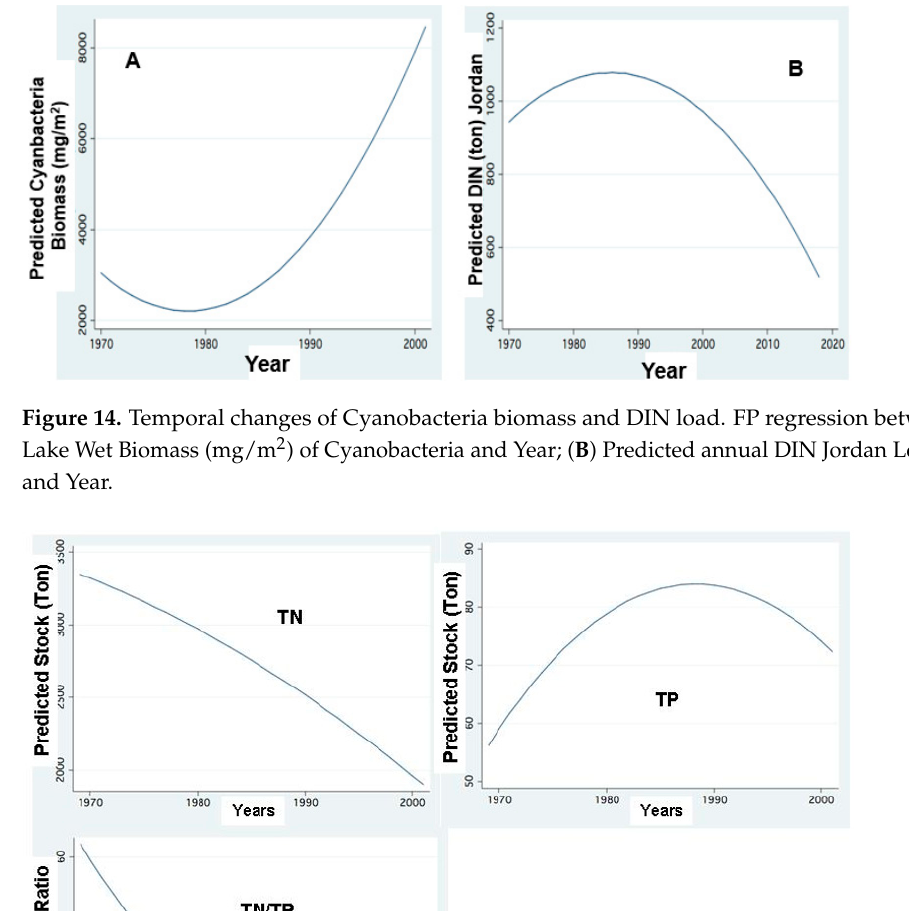
Figure 13. The relation between DIN and Cyanobacteria and Jordan discharge:FP regression: ( A ) Jordan Discharge (mcm/y) and Dissolved Inorganic Nitrogen(DIN) load (ton); ( B ): Wet Biomass of Cyanobacteria (mg/m 2 ) and Jordan DIN annual loads.